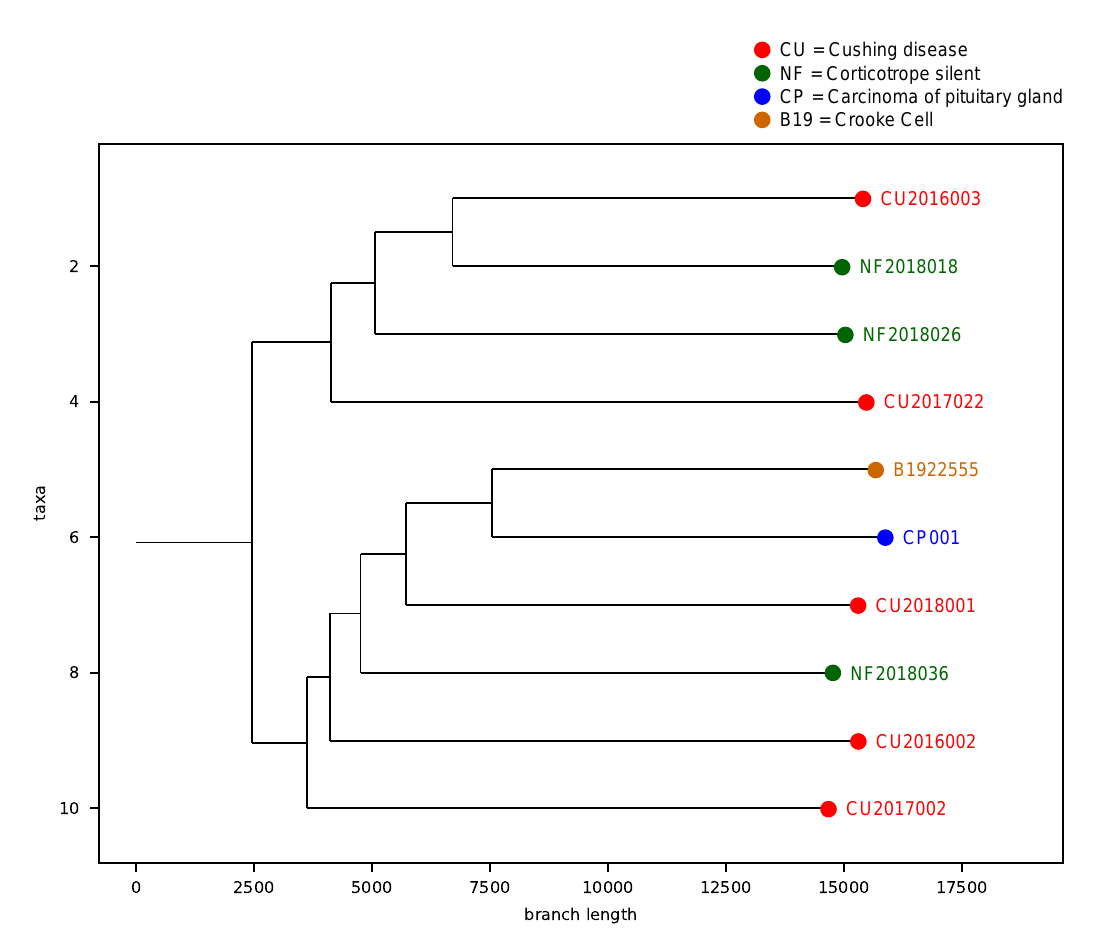
Figure 5. Phylogenetic analysis of the corticotroph tumors. The theoretical evolutive development of the ACTH-CA, departing from the SCA shows two main clades. The first clade, characterized by ATF7IP gene, comprises 2 of the 3 SCA and 2 of the 5 ACTH-adenomas causing CD. The second clade is characterized by the gene encoding MSH3 and includes the CCA, the ACTH-CA, one of the 3 SCA and 3 of the 5 most aggressive ACTH adenomas causing CD, including the adenoma of the patient with Nelson syndrome. Red dots represent the Cushing Disease provoking adenomas, green dots represent the silent corticotroph tumors, brown dot represent the Crooke cell adenoma and the blue dot represent the corticotroph